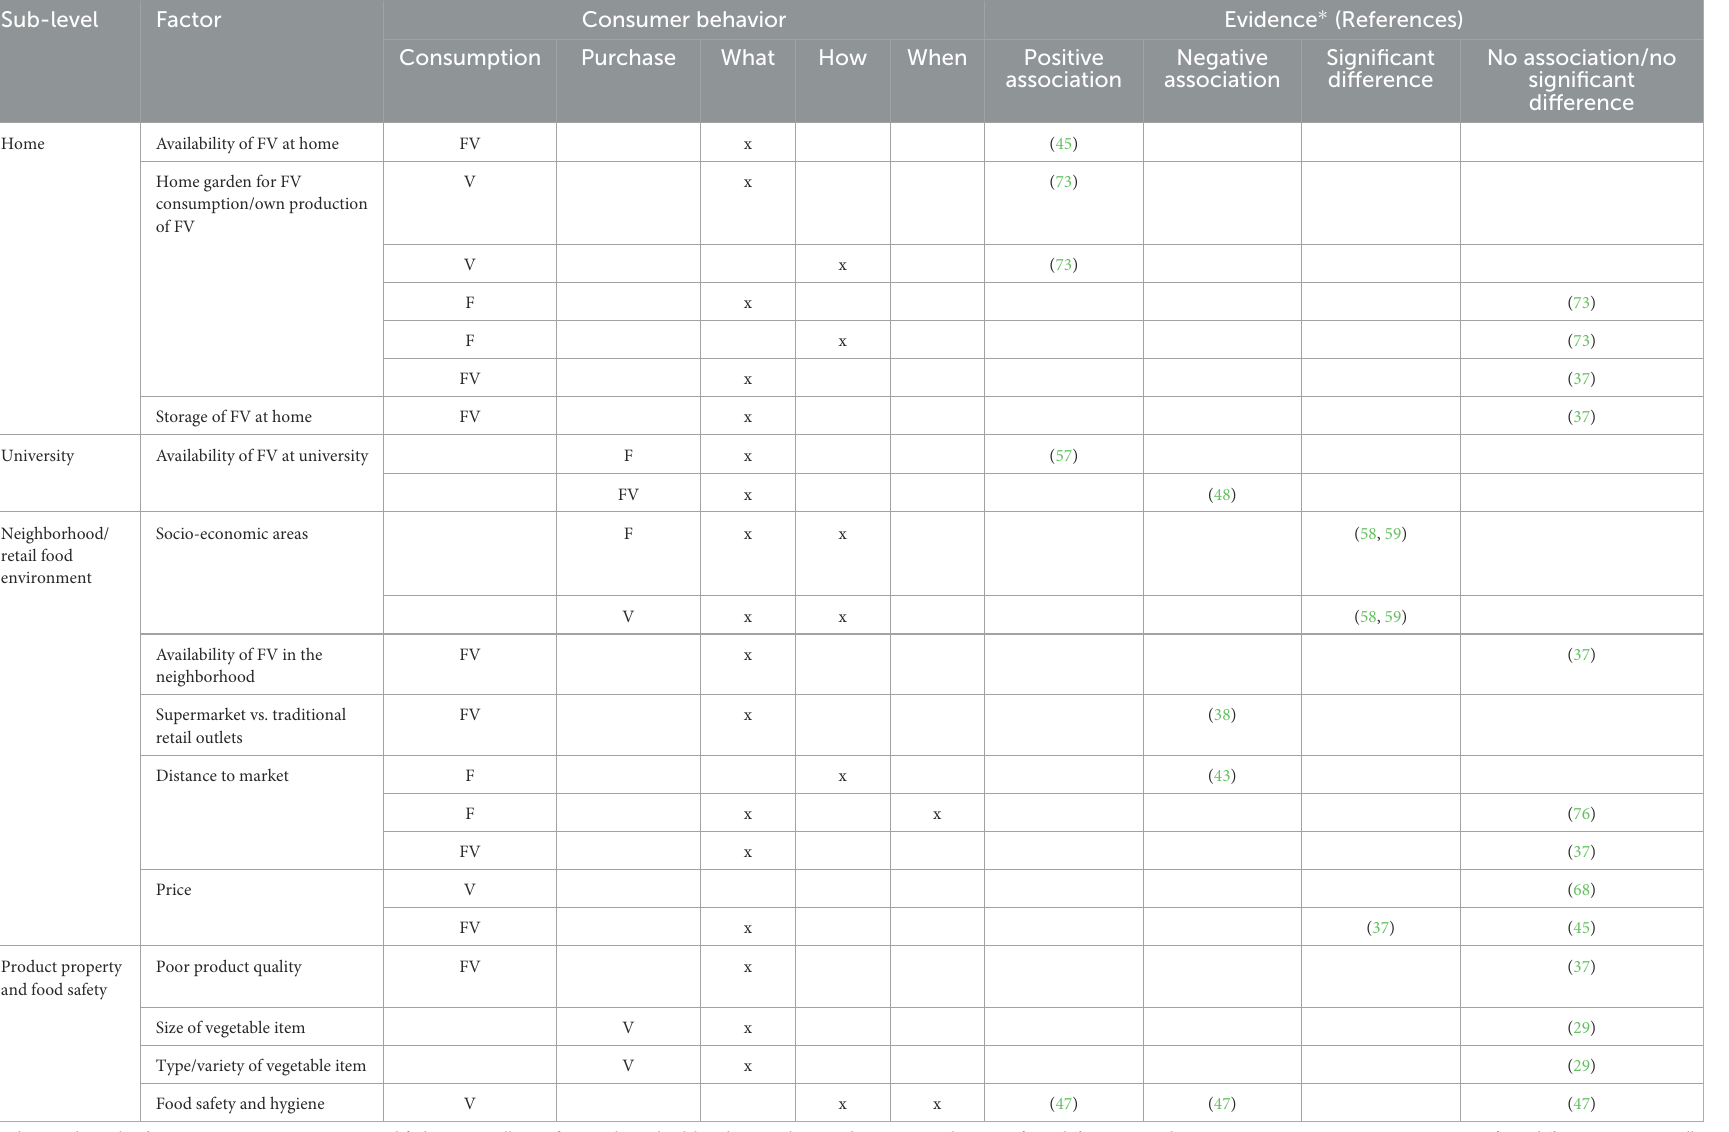
TABLE 4 Physical